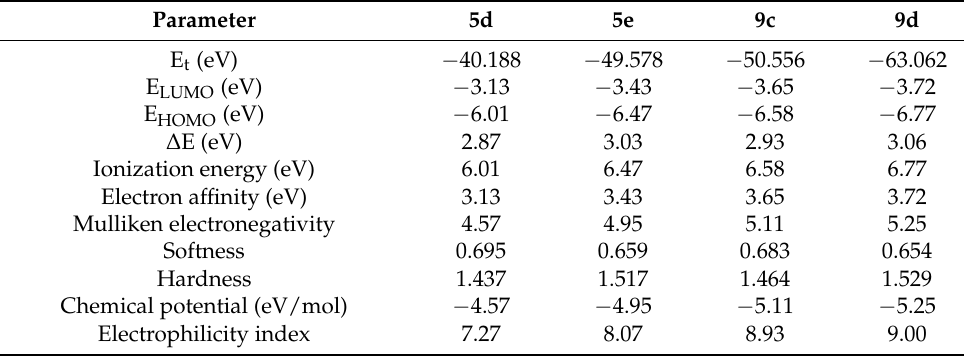
Table 2. Quantum chemical parameters of compounds 6d, 6e, 10c and 10d.